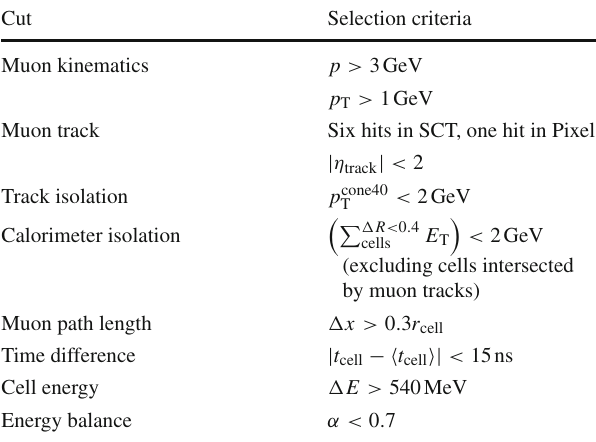
Table 11 Selection criteria used to evaluate the TileCal time resolution for muons from 2011 collision data. The first four criteria apply to the muon track. For the track and calorimeter isolation criteria the sums are over the non-muon tracks and cell energies, respectively, within a cone of size (cid:4) R = 0 . 4 centred on the passing muon. The last four criteria are used to select individual cells along the muon track, the variables are defined in the text